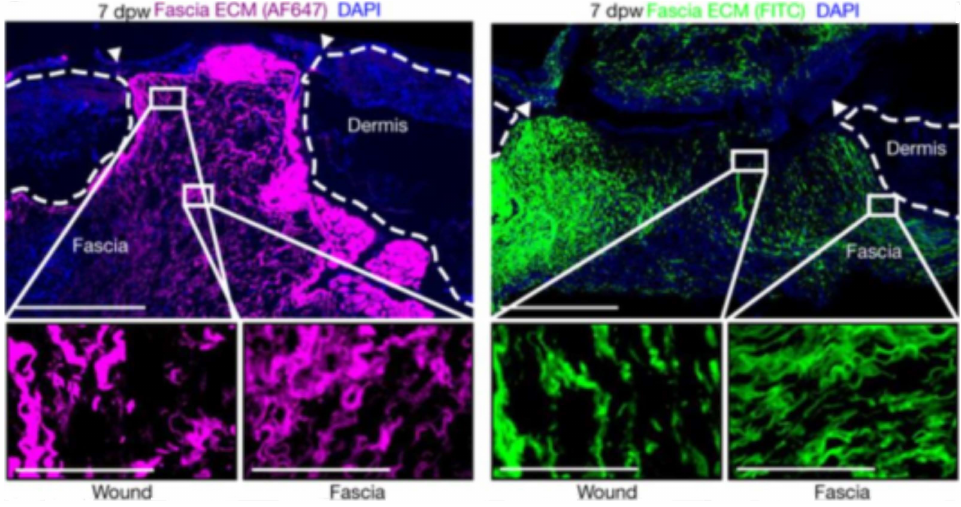
Figure 4. This image is a reference image [27], fluorescence images of wounds on day 7 of fas- cia labelling experiment, nuclei (blue), labelled fascia (magenta, green), scare bar: 500 µ m (top), 100 µ m